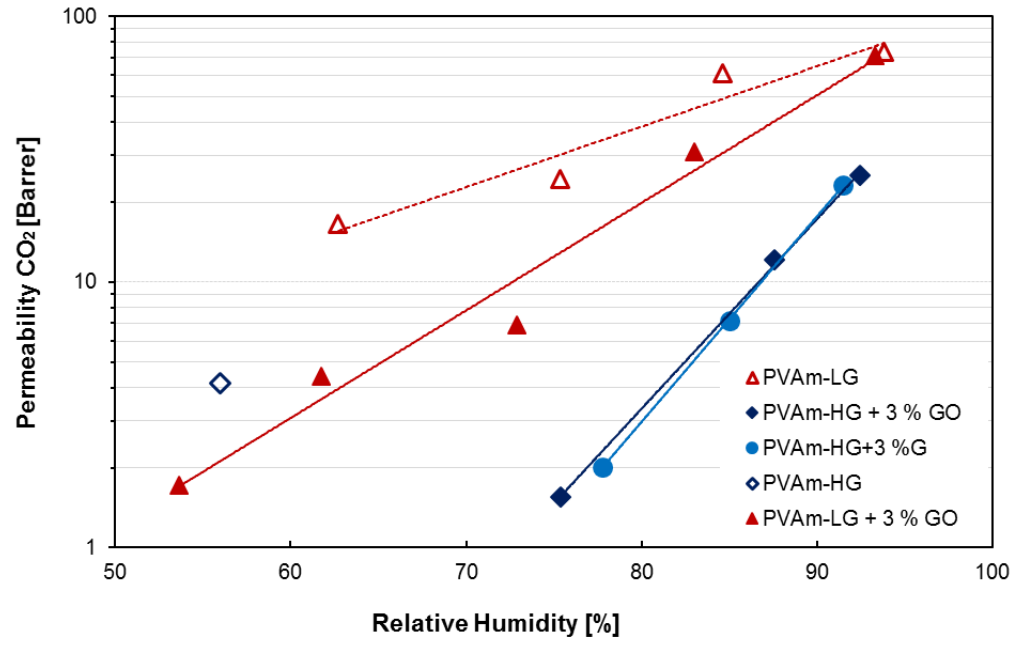
Figure 10. Single gas CO 2 permeability of PVAm based films with respect to relative humidity, with trend lines . Table 2. Permeselective properties of the di ff erent membranes PVAm